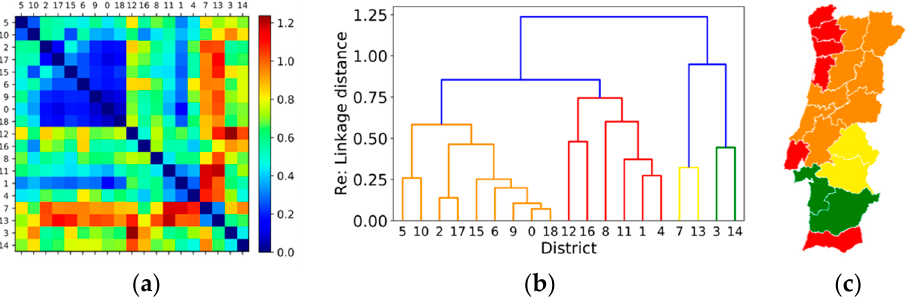
Figure 13. Reactivations (Re): ( a ) Dissimilarity matrix; ( b ) Clusters by relative annual profile of distribution; ( c ) Clusters in geographic location (cophenetic coefficient: 0.79).